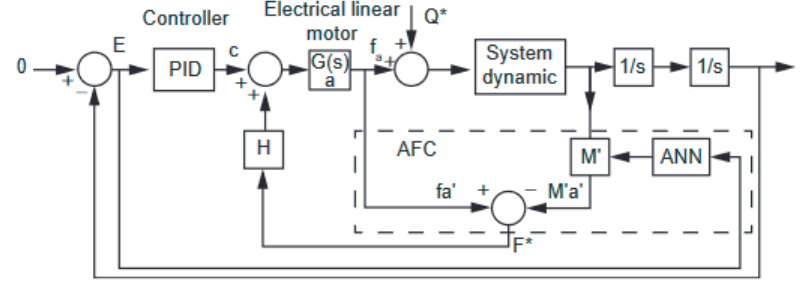
Figure 27. An intelligent controller via an ANN algorithm [74].